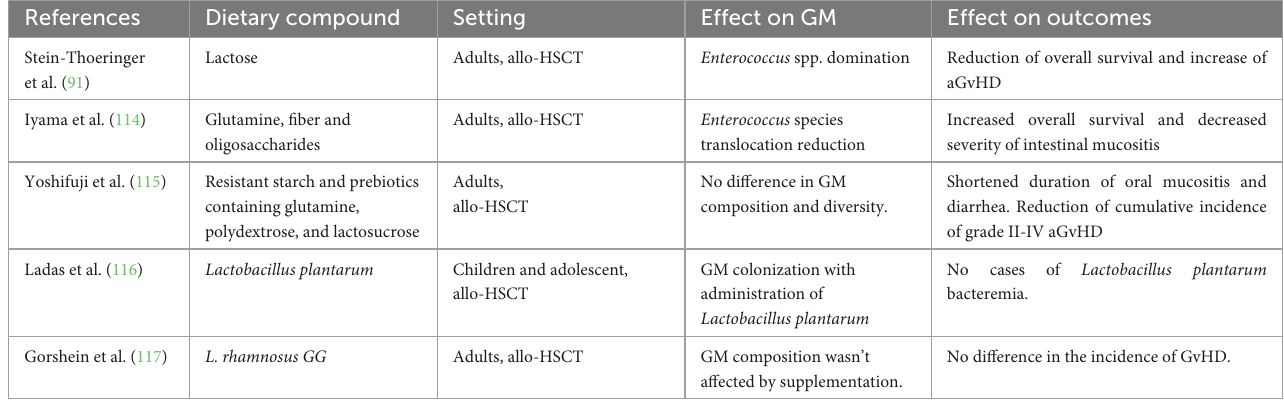
TABLE 2 Main studies on gut microbiota modulation in